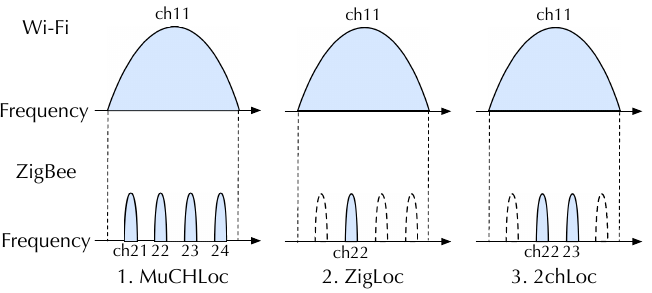
Figure 7. ZigBee channels used in MuCHLoc, ZigLoc and 2chLoc localization.